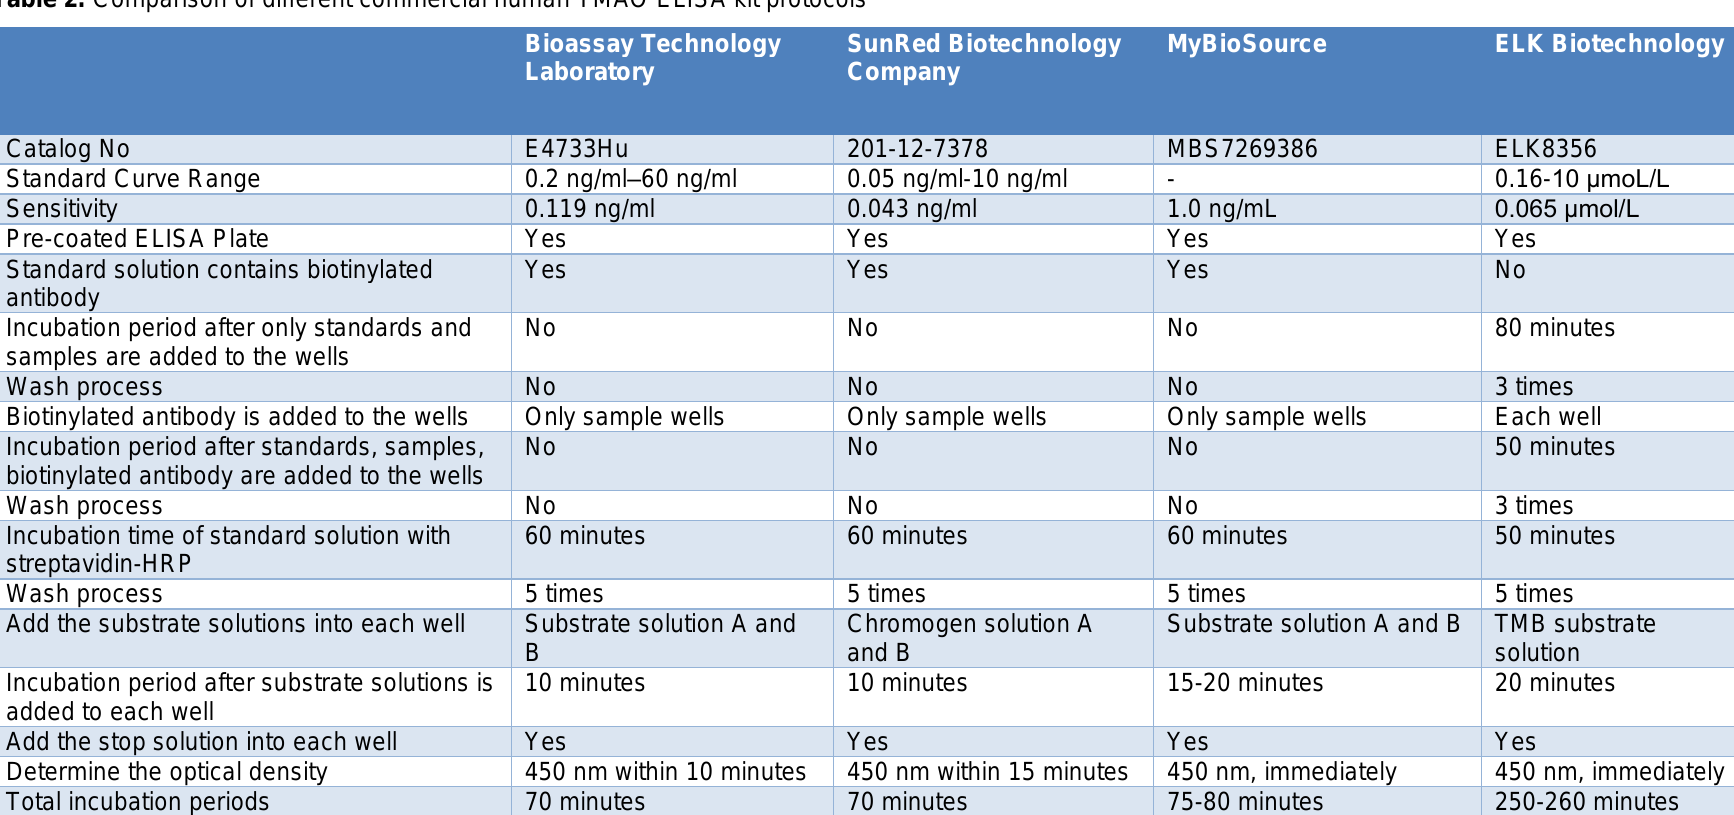
Table 2: Comparison of different commercial human TMAO ELISA kit